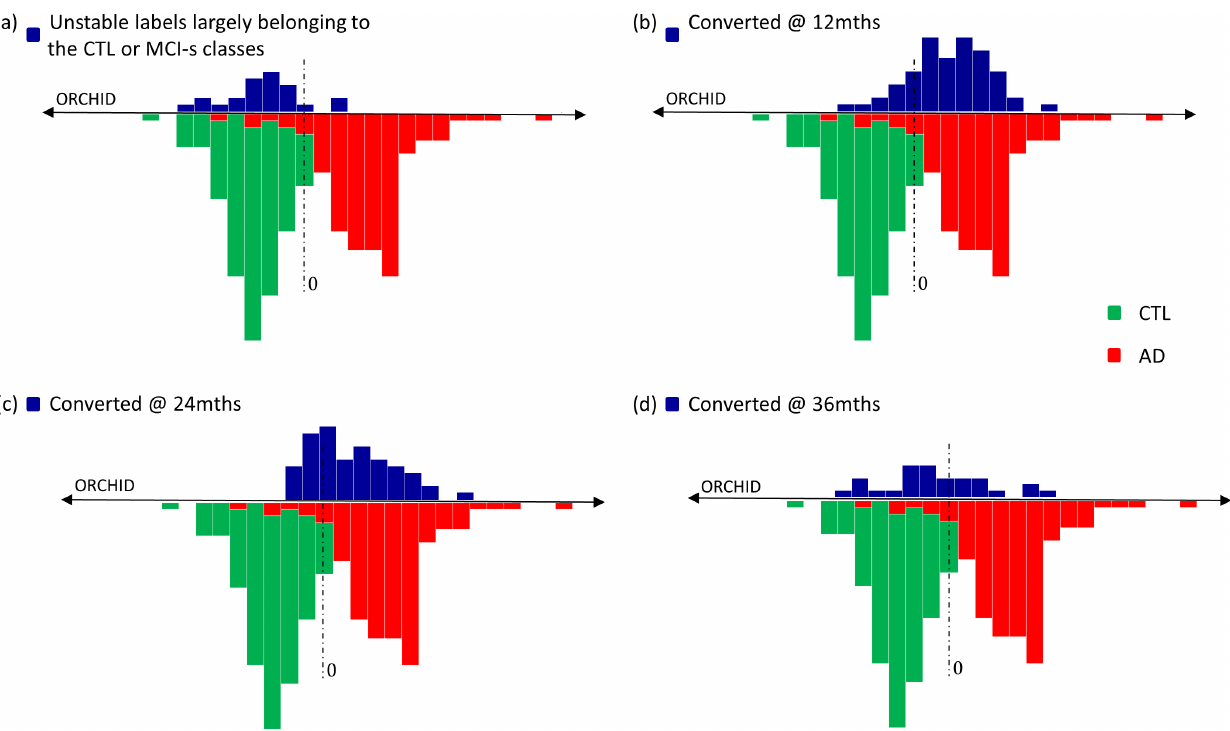
Figure 4. Distribution of the ORCHID (Ordinal Regression Characteristic Index of Dementia) score extracted from for the ADNI dataset representing the disease progressive continuum spanning CTL to MCI-s to MCI-c to AD. The lower portion of each plot represents the distributions for the CTL class (green) and the AD class (red). (a) represents the distribution of subjects with unstable labels across follow-ups, most of which appear to belong to either the CTL or MCI-s classes (N=24). (b) represents the distribution of those who convert to AD by 12 month follow-up (N=62) (i.e. MCI-c: the sample used for training and testing the ADNI-based ORGP model). (c) represents the distribution of those who convert to AD between the 12 and 24 month follow-up (N=58). (d) represents the distribution of those who convert to AD between the 24 and 36 month follow-up (N=29).